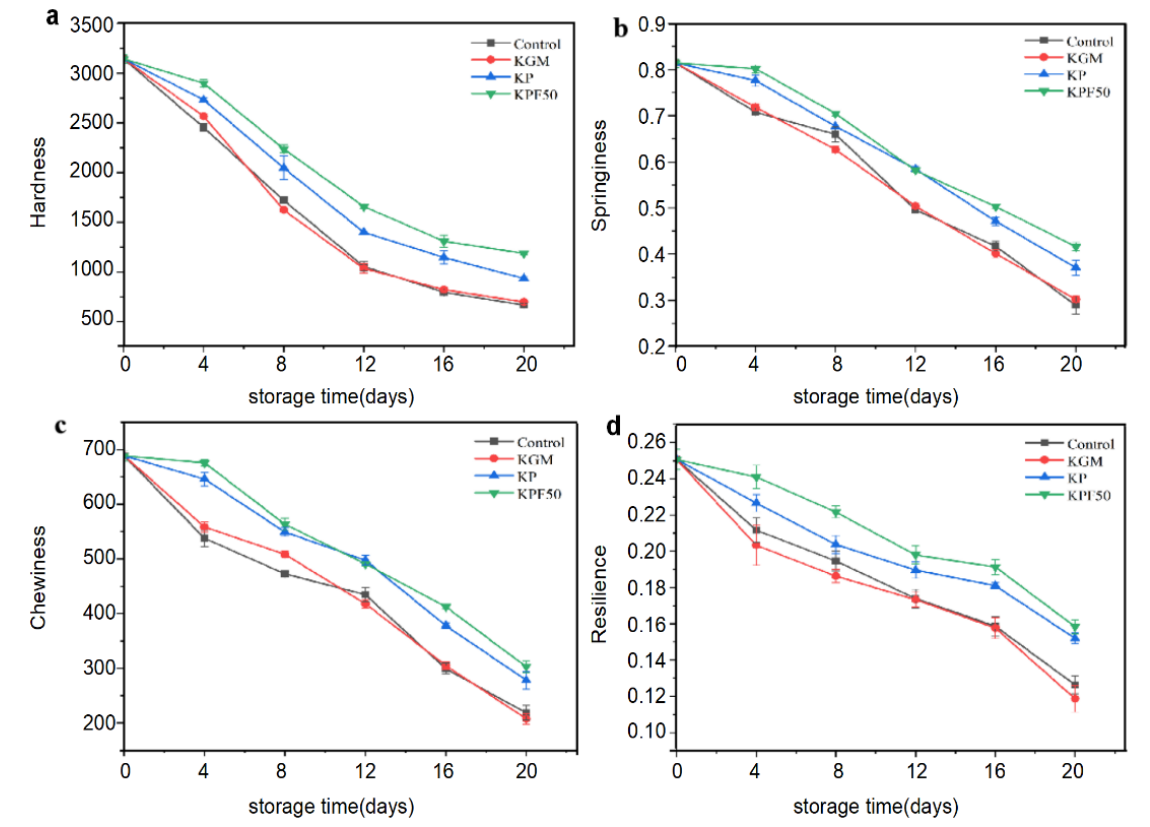
Figure 2. The texture attributes of sea bass fillets during refrigeration storage: ( a ) hardness; ( b ) elasticity; ( c ) chewiness; ( d ) recovery.